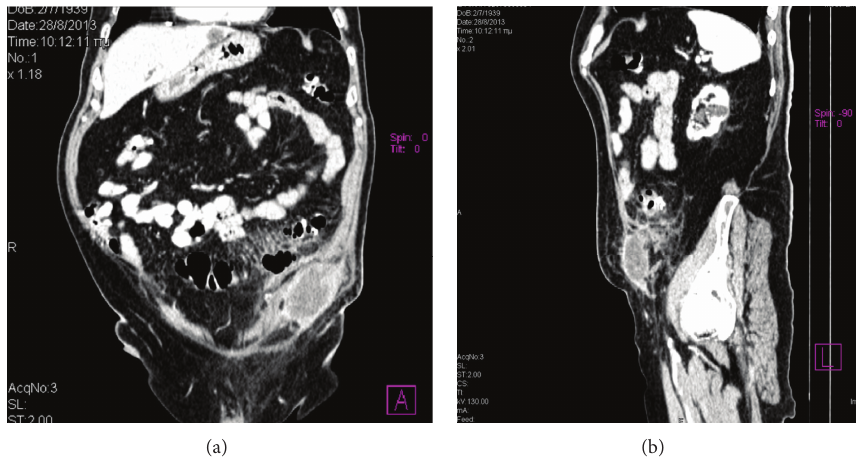
Figure 3: Coronal (a) and sagittal (b) MPR images make more evident the presence of the abscess cavity and its relationship to the abdominal wall, the fat stranding, and the presence of extraluminal free air collection. In image (b), we notice the communication between the abscess and the intraperitoneal inflammatory